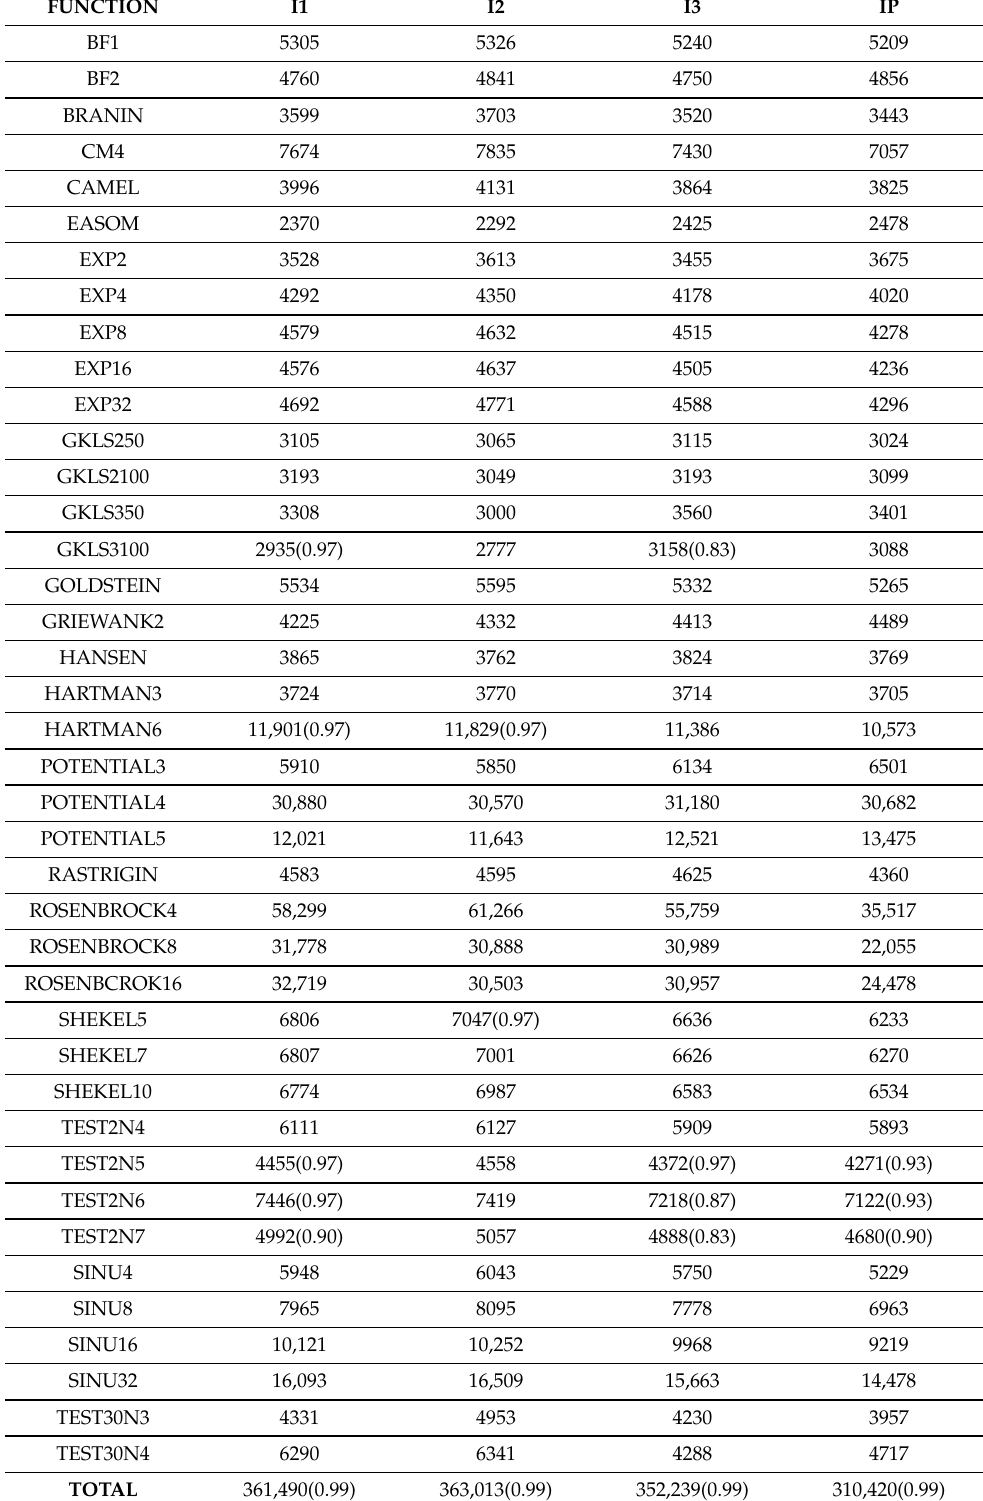
Table 6. Experiments with the proposed stopping rule without the gradient